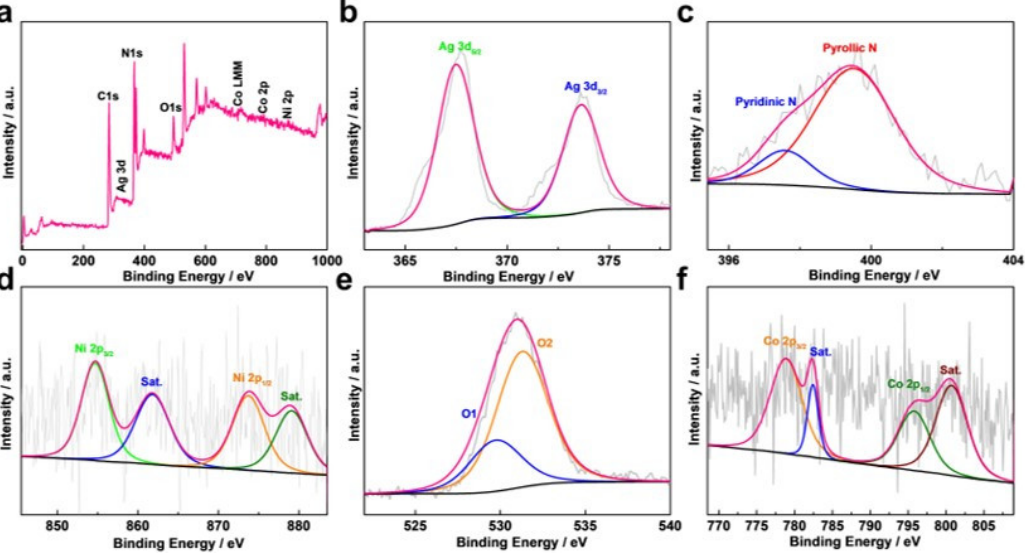
Figure 4. The XPS spectra of ( a ) Ag/NiCo 2 O 4 -NC sample; ( b ) Ag 3d, ( c ) N 1s, ( d ) Ni 2p, ( e ) O 1s and ( f ) Co 2p.